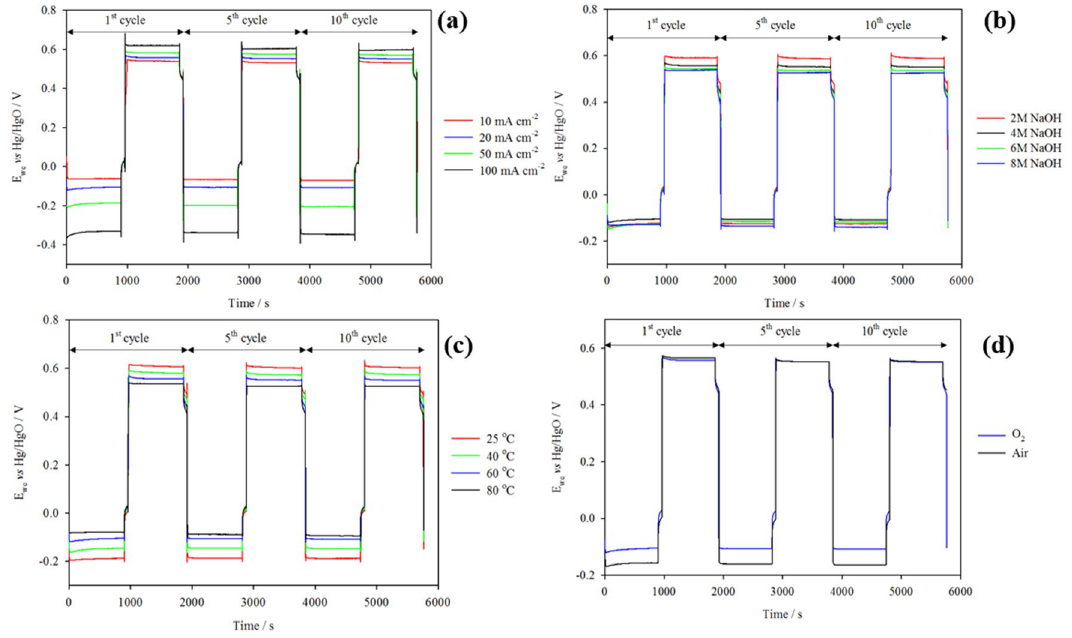
Figure 7. Effects of ( a ) current density, ( b ) electrolyte molarity, ( c ) temperature and, ( d ) O 2 purity on oxygen electrode performance in static electrolyte 4 M NaOH + 0.3 M ZnO at 333 K, O 2 or compressed air was supplied at 200 cm 3 min −1